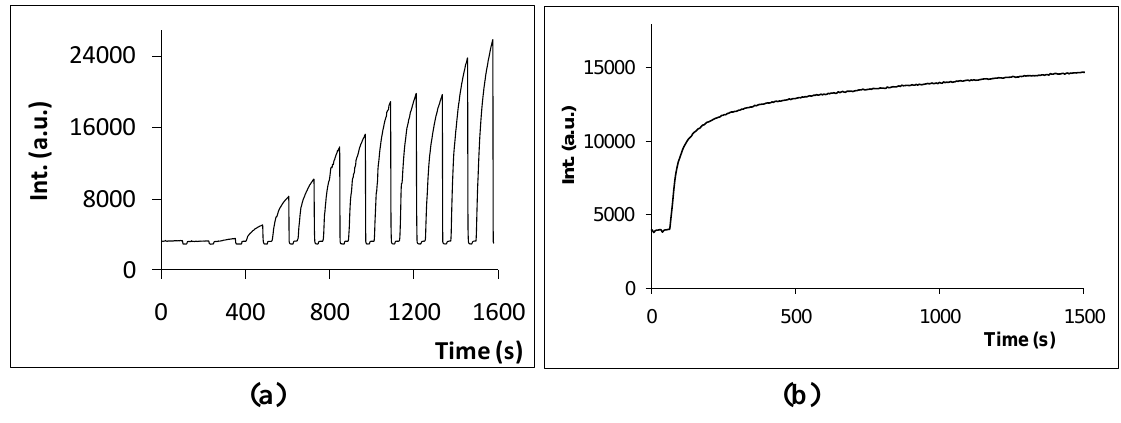
Figure 5. Detection NO present in aqueous solution as a result of production from the reaction of nitrite and sulfuric acid (a) and from the hydrolysis of DEANO